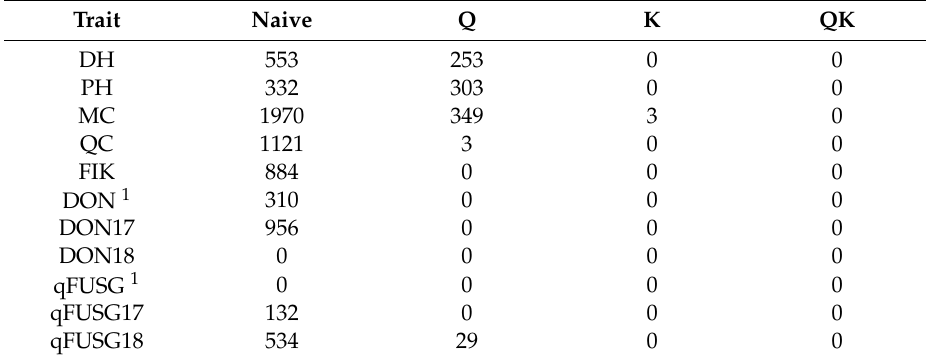
Table 4. The number of significant associations for each model and for each trait. Significance